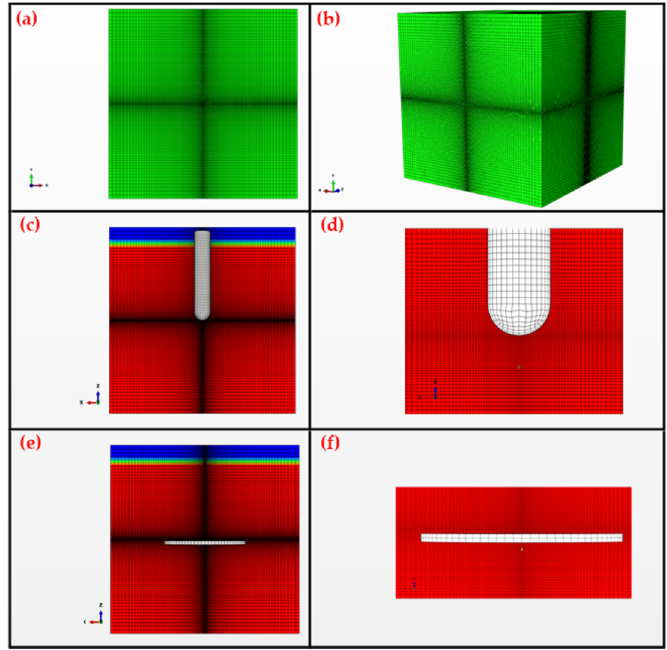
Figure 5. Finite element model of ABAQUS-Euler: ( a ) model main view; ( b ) model side view; ( c ) material distribution inside the Euler area of the hemisphere target; ( d ) enlarged view of the mesh around the hemisphere target; ( e ) material distribution inside the Euler area of the flat plate target; ( f ) enlarged view of the mesh around the flat plate target.